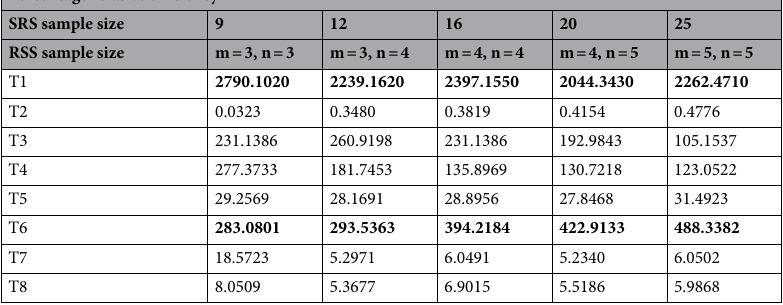
Percentage relative efficiency SRS sample